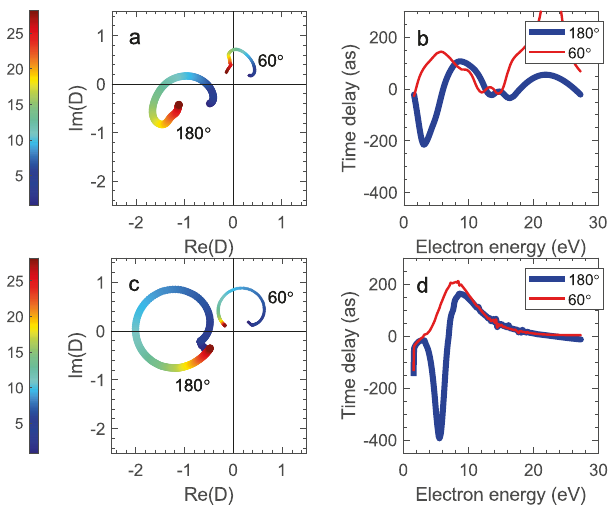
Fig. 3 Experimental and computed PDA curves and time delays. a PDA curves and b time delays for the experiment at emission angles of 180° (thick line, blue in b ) and 60° (thin line, red in b ). The corresponding data for the computed cross sections are given in ( c ) and ( d ). The color scale on the left gives the photoelectron energy in eV for the curves in the complex